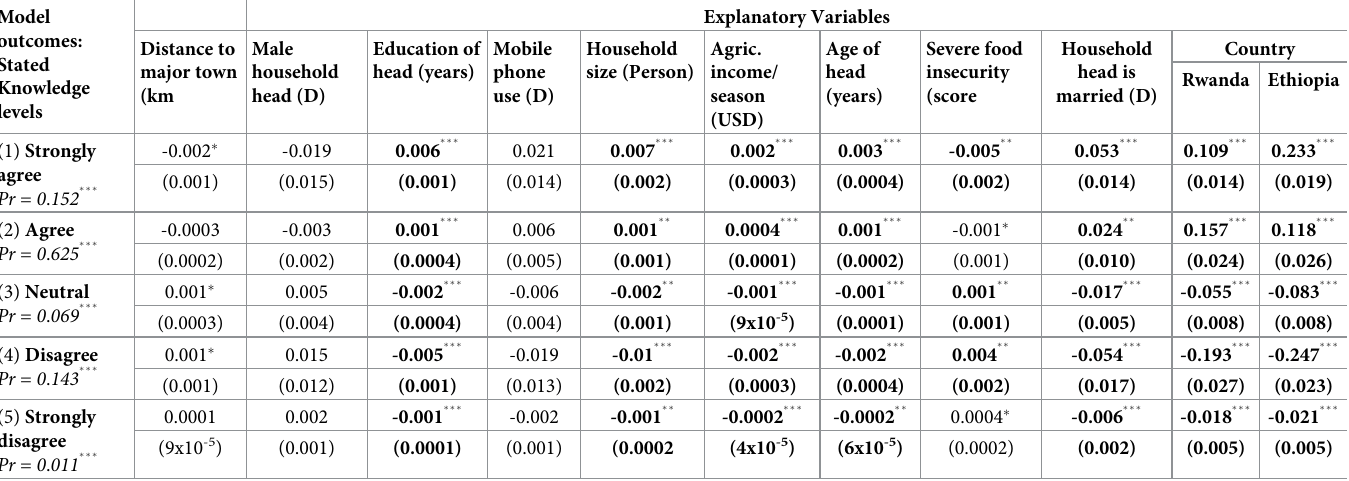
Table 6. Marginal effects after generalized ordered logit for knowledge on CBE practices. Model